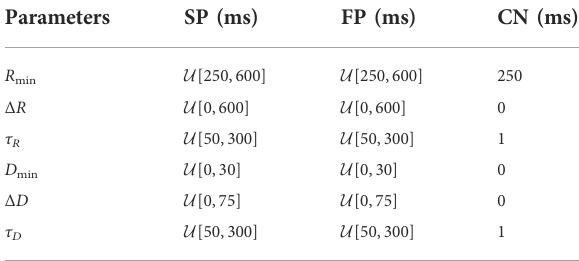
TABLE 1 Model parameters used for the sensitivity analysis.